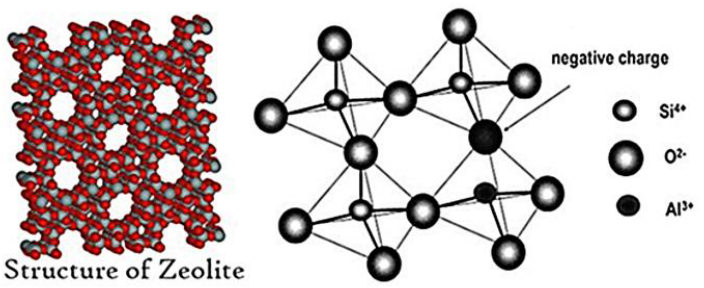
Figure 8. The zeolite structure. Reproduced with permission from [89] .